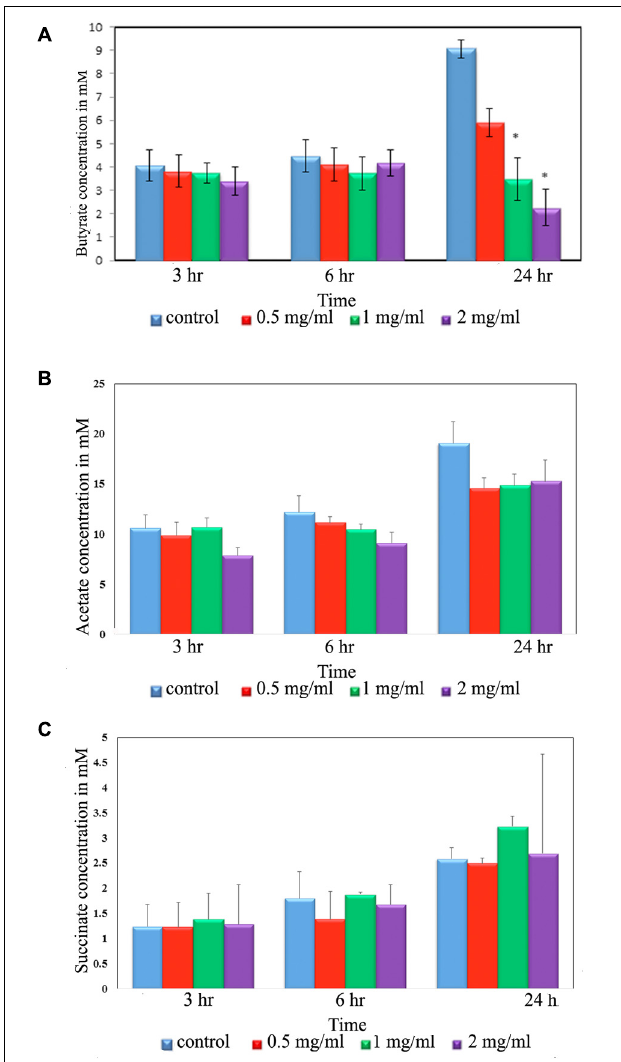
FIGURE 4 | Short chain fatty acid (SCFA) production by rat intestinal bacteria after exposure to aloin. Fecal samples for SCFA analysis were collected at three different time points (3, 6, and 24 h). The SCFA production was measured by HPLC method. The presented data are averages of four independent experiments. (A) Butyrate production, (B) acetic acid production, and (C) succinate production. Values of P < 0.05 or below considered as statistically significant. Asterisks indicates statistical significance ( ∗ p <